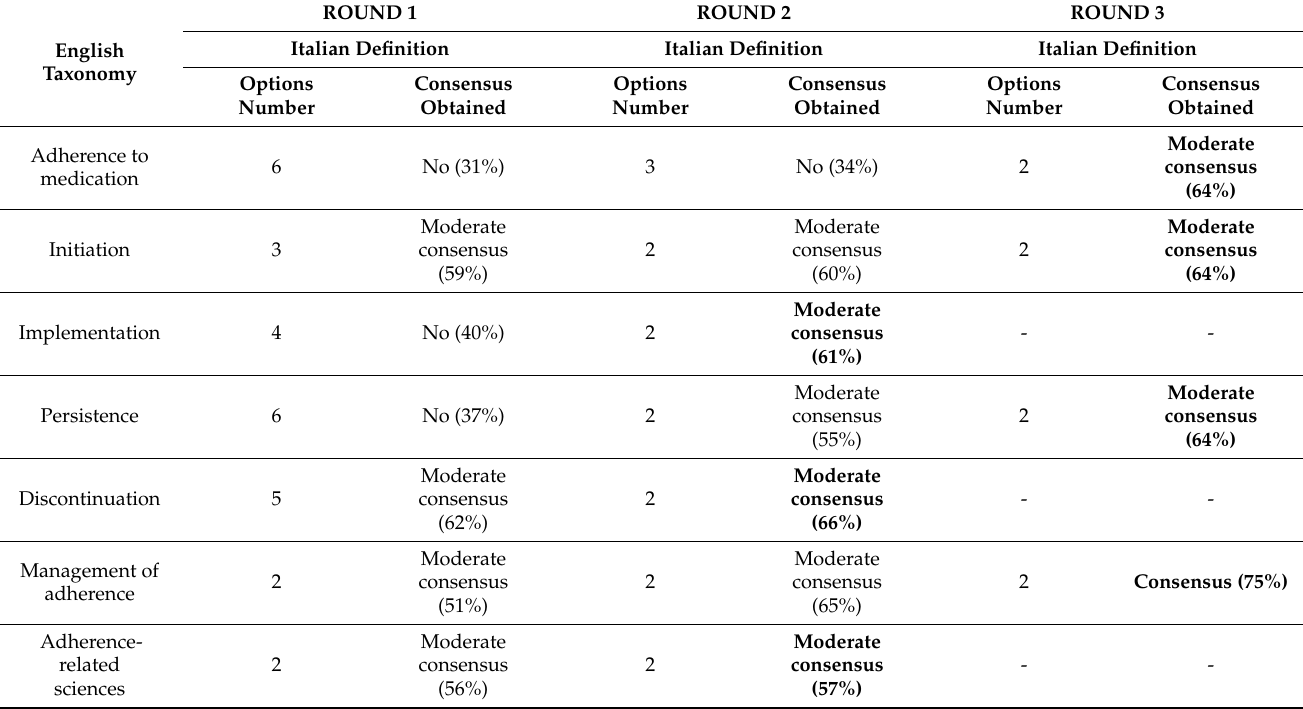
Table 2. Round needed for consensus reaching for Italian translation of definitions.